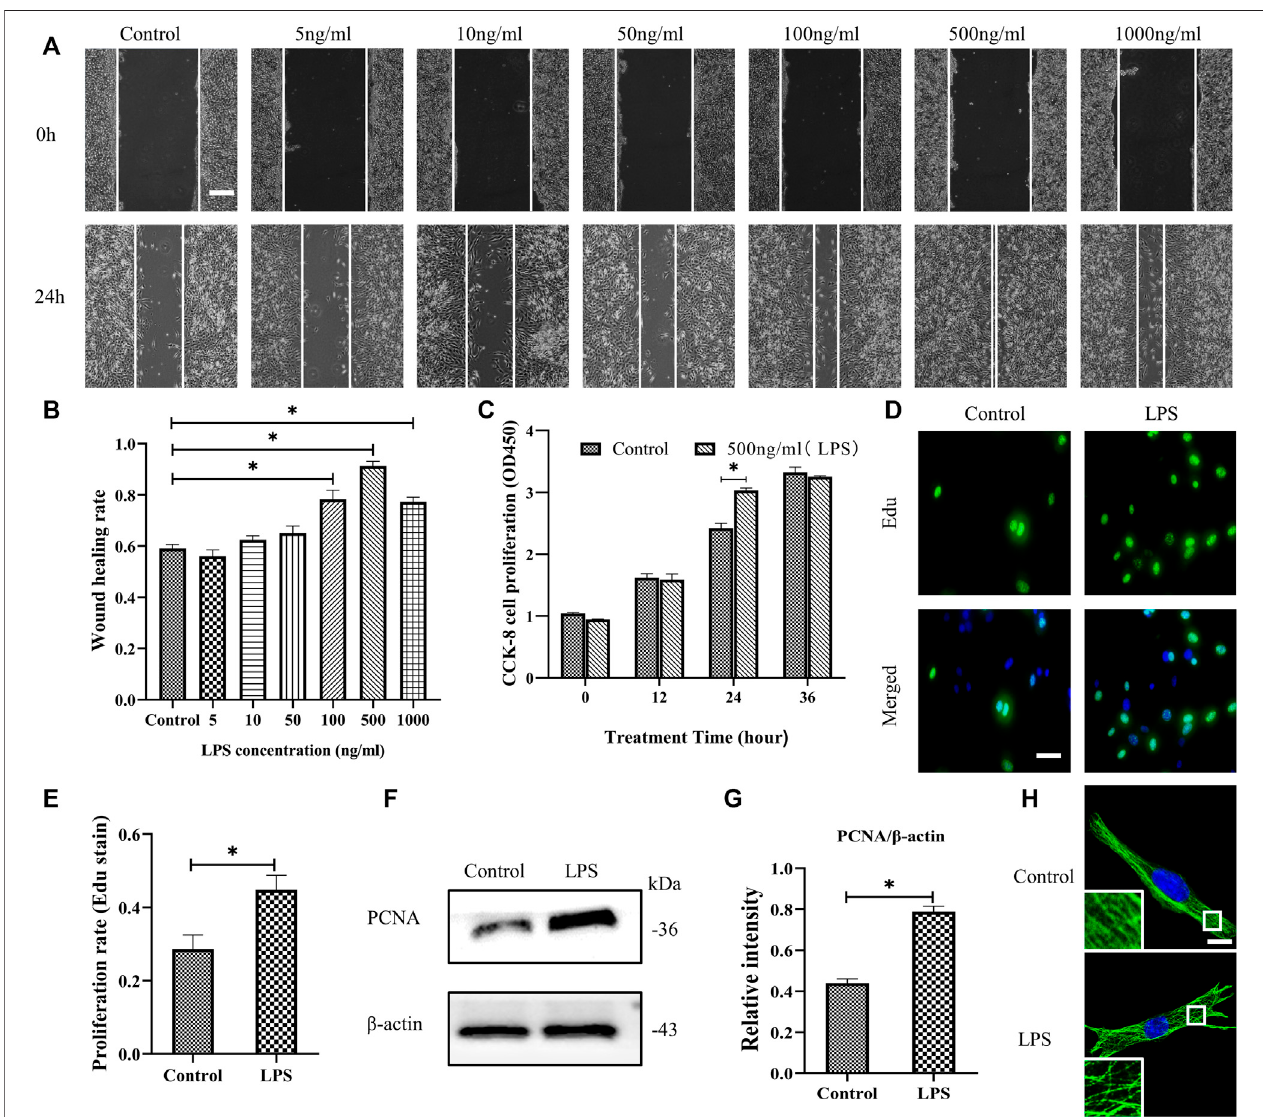
FIGURE 1 | LPS promotes the migration and proliferation of HDF and MT depolymerization. (A) Scratch wound healing assays were performed to examine HDF migrationwithorwithoutLPS(5,10,50,100,500and 1,000 ng/ml)for24 h.Representativepicturesofthescratchwoundareshown.Bar, 200 μ m,and (B) theimages were quantitatively analyzed ( n (cid:1) 5). (C) HDF was subjected to LPS (500 ng/ml) for 12, 24 and 36 h to detect cell proliferation using the CCK-8 assay ( n (cid:1) 6). (D) HDF proliferationwasdetectedafter24 hwithorwithoutLPSbyEdustainingand (E) quantitative analysis( n (cid:1) 5).NucleiwerestainedwithHoechst33342.Themerged image is to show the proportion of proliferating cells (green) to total cells (blue). Bar, 20 µm. (F) Western blotting was performed to detect PCNA with or without LPS (500 ng/ml) treatment and (G) quantitative analysis ( n (cid:1) 5). (H) Representative confocal tubulin immuno fl uorescence images showing the MT structure with or without LPS (500 ng/ml)for 24 h.The insertsshow high-magni fi cation images oftheMT network.Bar, 10 µm.LPS, lipopolysaccharide; PCNA, proliferatingcell nuclearantigen. The results are shown as means ± SEM. * p < 0.05 was considered to be signi fi cant.